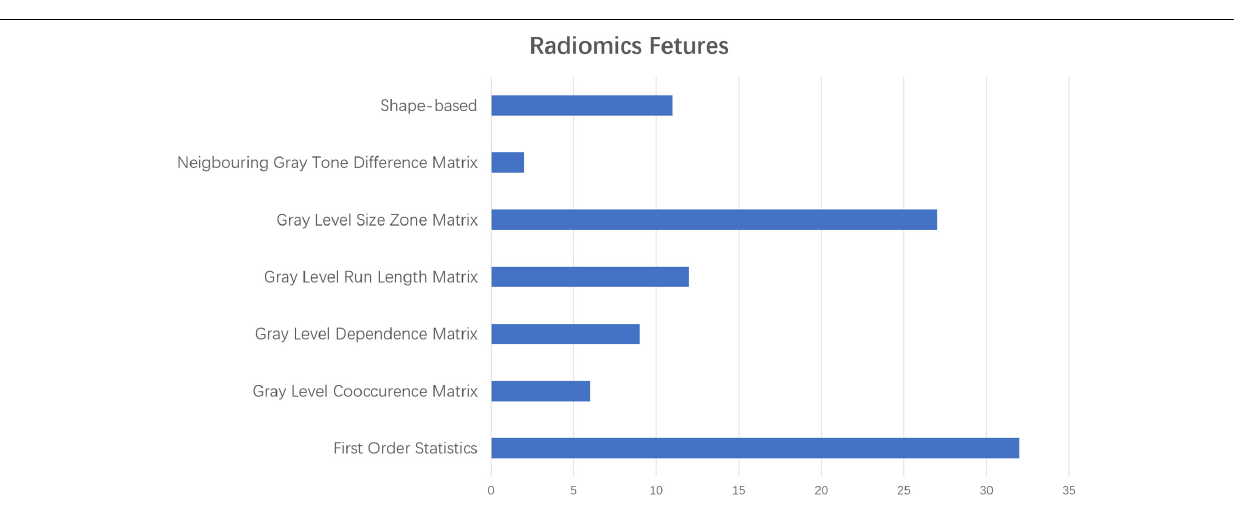
FIGURE 6 | The different proportions of radiomic characteristics in the process of predicting ad with radiomic characteristics in the low-order